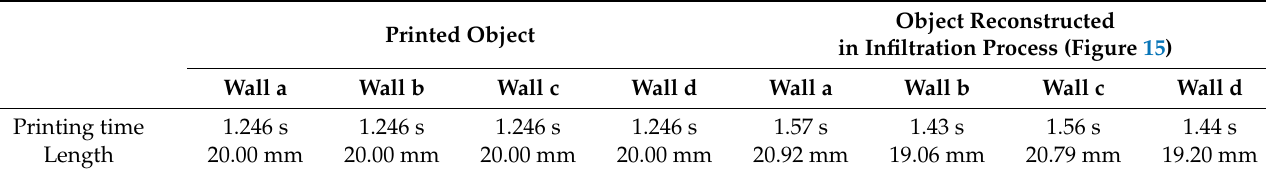
Table 3. The reproduction accuracy of the tetrahedron (Figure 7c).